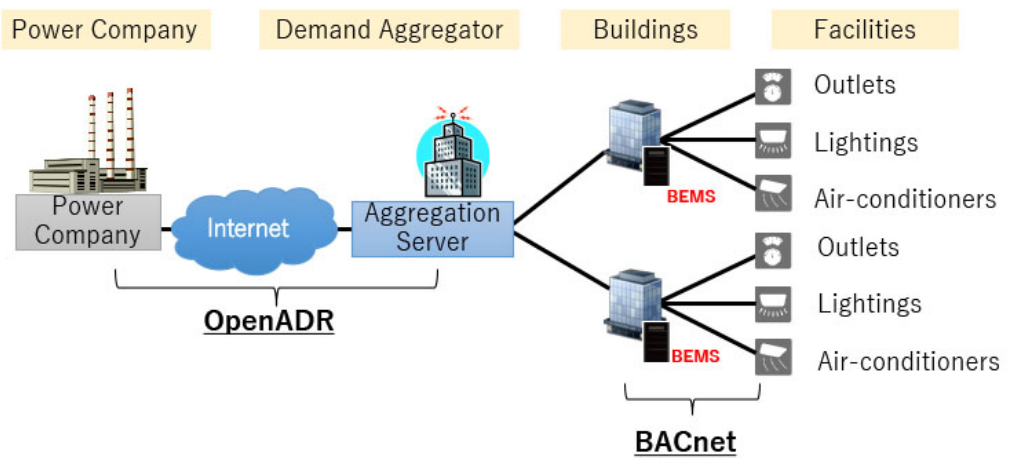
Figure 1. Overview of demand management system for